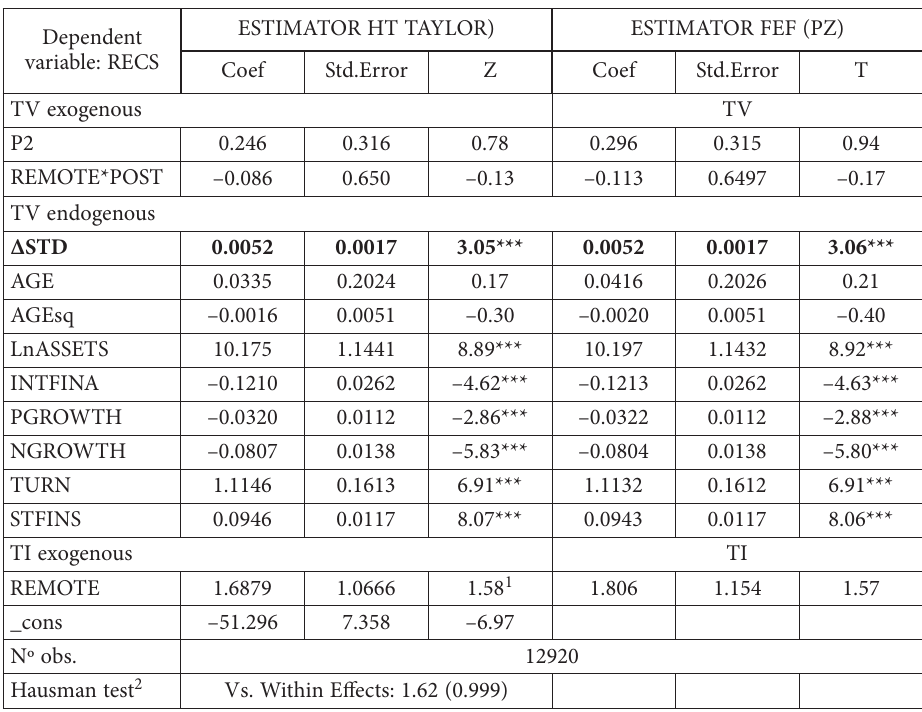
Table 6. Testing the complementary and substitution